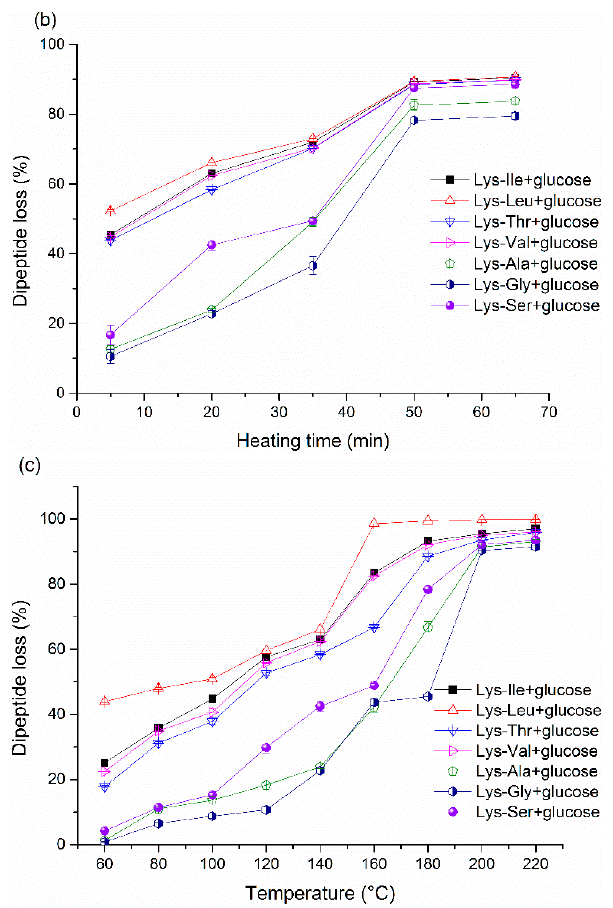
Figure 3. Peptide loss in the heat-treated dipeptide-glucose mixtures, ( a ) dipeptide-glucose mixtures at different initial molar ratios, time 20 min, temperature 140 °C; ( b ) dipeptide-glucose mixtures at various heat-treated times, initial molar ratio 1:1, temperature 140 °C; ( c ) dipeptide-glucose mixtures at different heating temperatures, initial molar ratio 1:1, time 20 min.